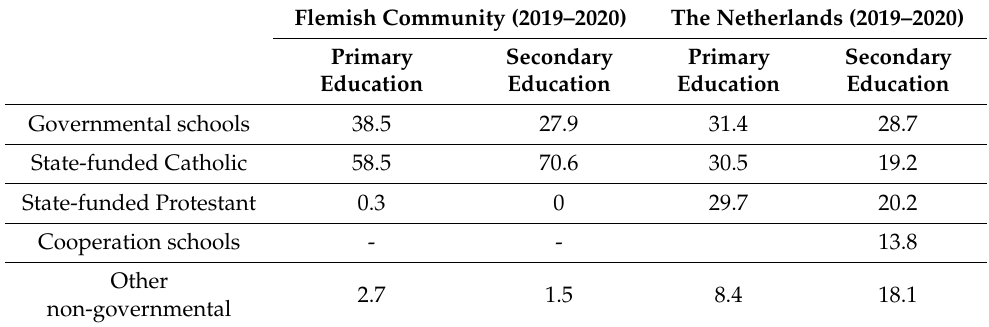
Table 2. Pupils (%) in governmental and state funded non-governmental schools in the Flemish Community and in the Netherlands (Source: statistisch jaarboek onderwijs 2019–2020 [Flemisch community] and Statistics Netherlands.